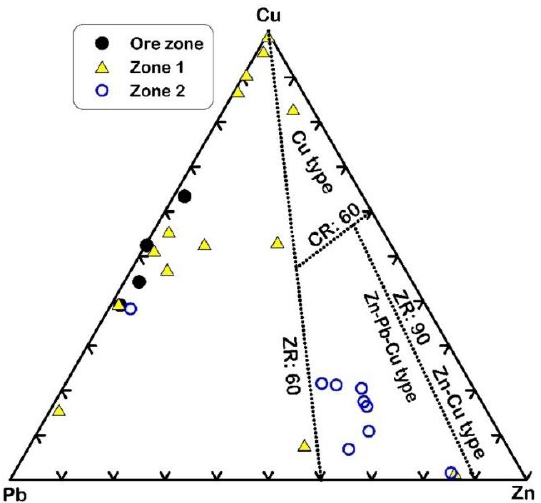
Figure 12. Metal content classification diagram after Large [50]. The ratios ZR = (100 Zn/(Zn + Pb) and CR= 100 Cu/(Cu + Zn) are based on the average ore grades in mass percent after Large [50].